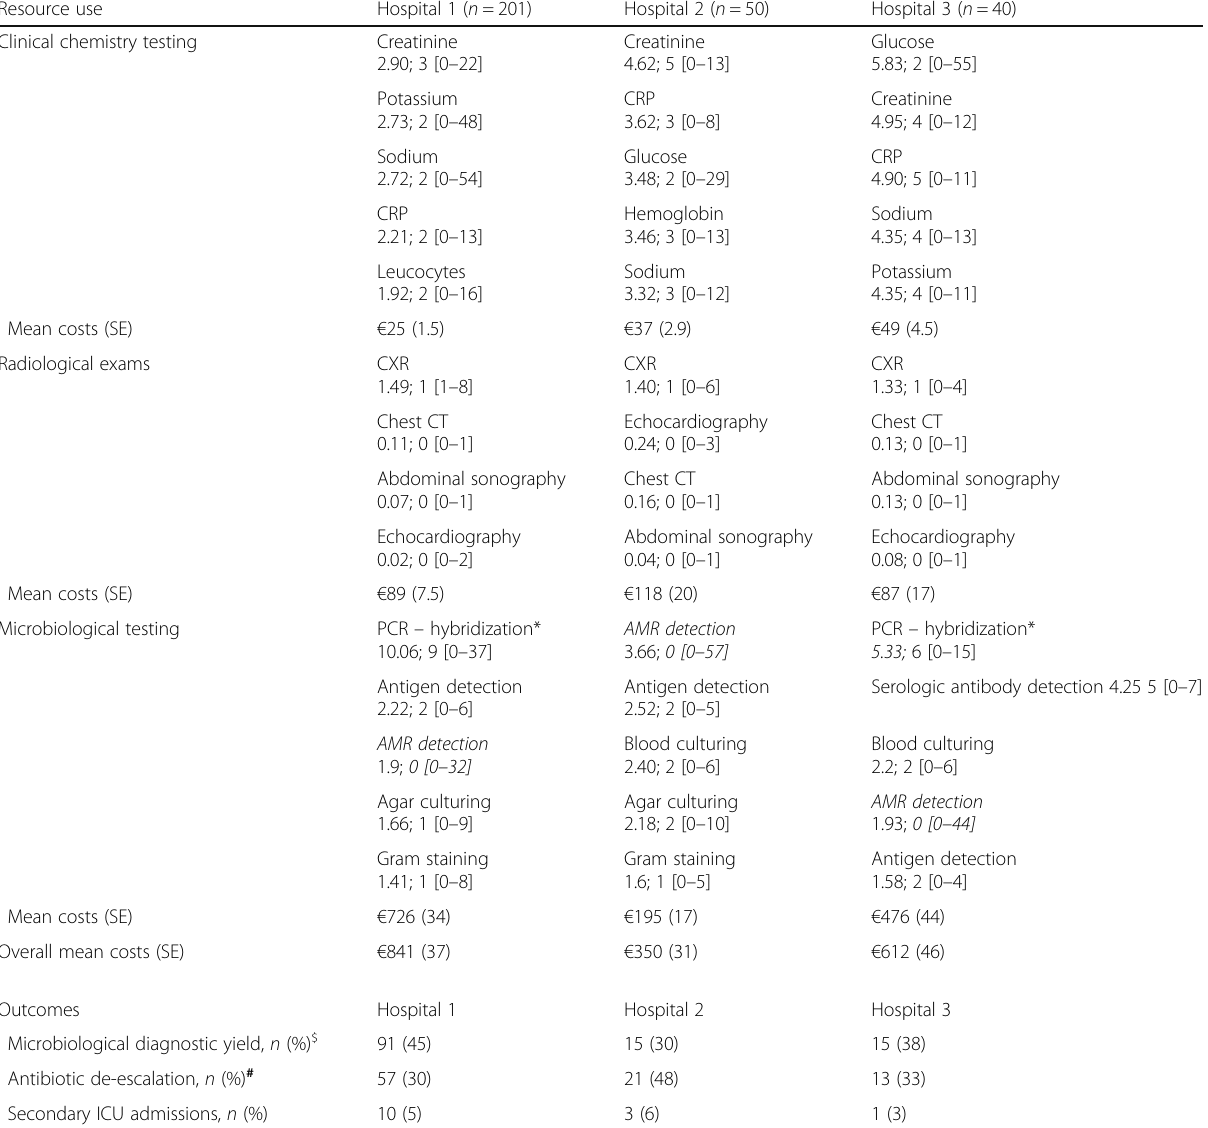
Table 1 Ranking of mean number of items and mean costs per patient plus